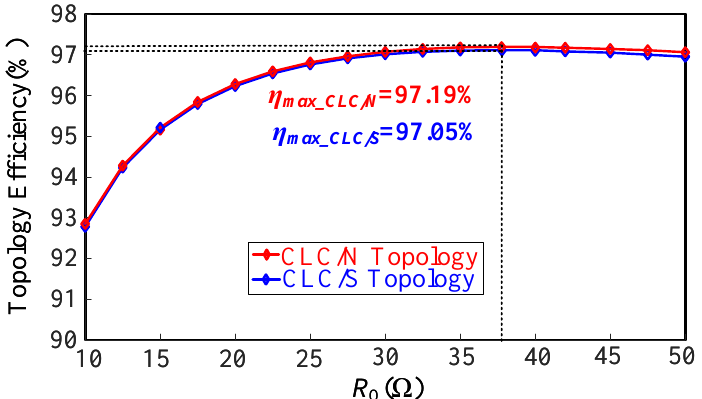
Figure 9. The efficiency profiles of the proposed CLC/N topology and CLC/S topology.